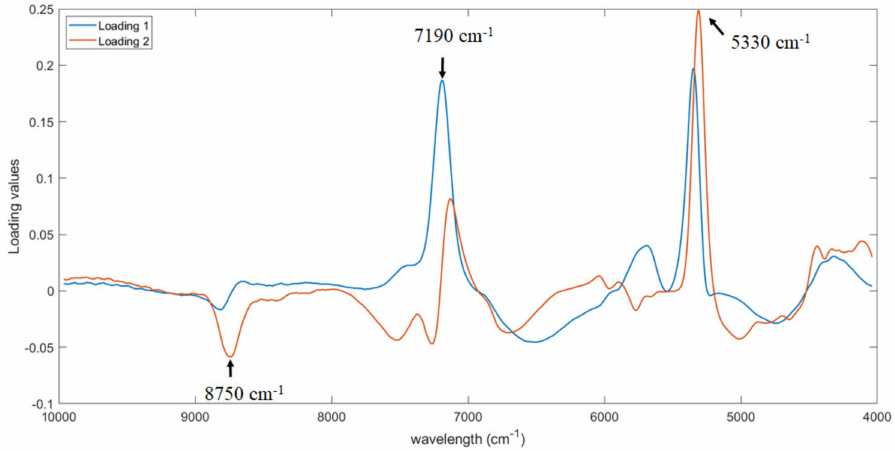
Figure 7. First two loadings of Partial Least Squares Regression (PLS) model for the prediction of